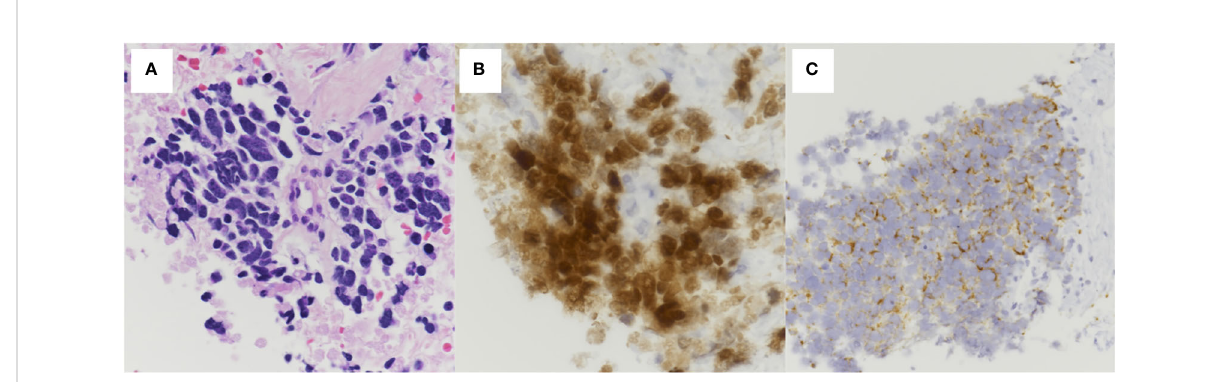
FIGURE 2 Histopathological fi ndings of the pulmonary tumor. (A) Hematoxylin and eosin staining showing dense sheet-like growth of bare nucleated atypical cells with increased chromatin (400× magni fi cation). Immunostaining showing positive (B) insulinoma-associated protein 1 (400×